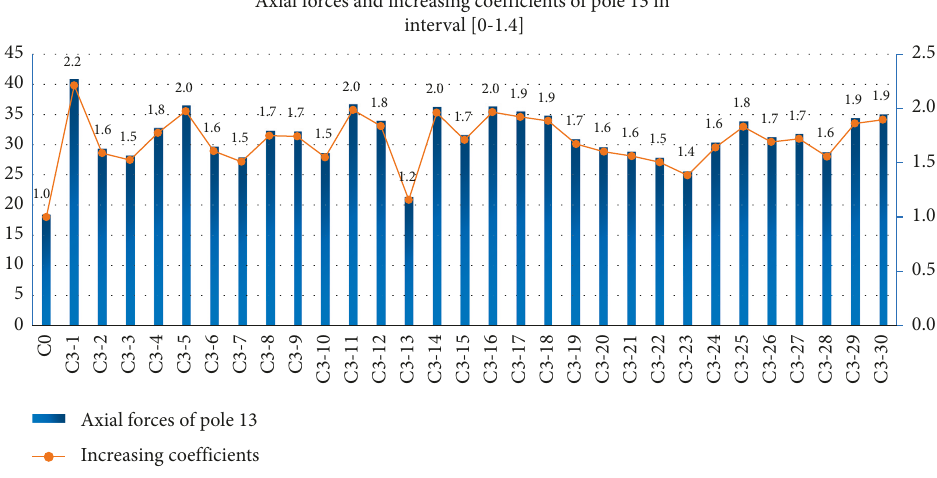
Figure 15: Axial forces and increasing coefficients of pole 13 in interval [0-1.4].